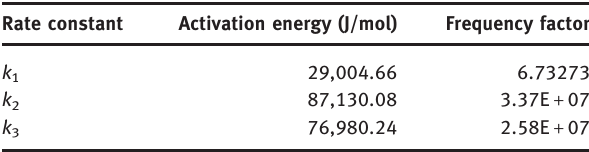
Table 2: Parameters of rate constants from Arrhenius